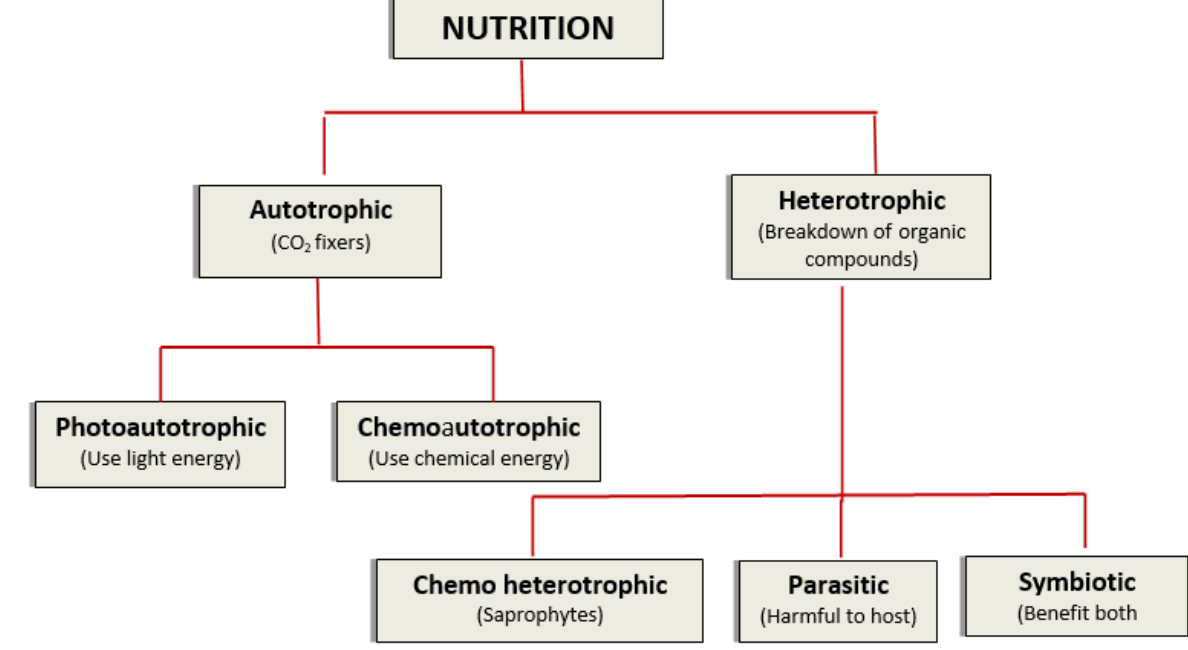
Figure 3: Nutritional diversity among